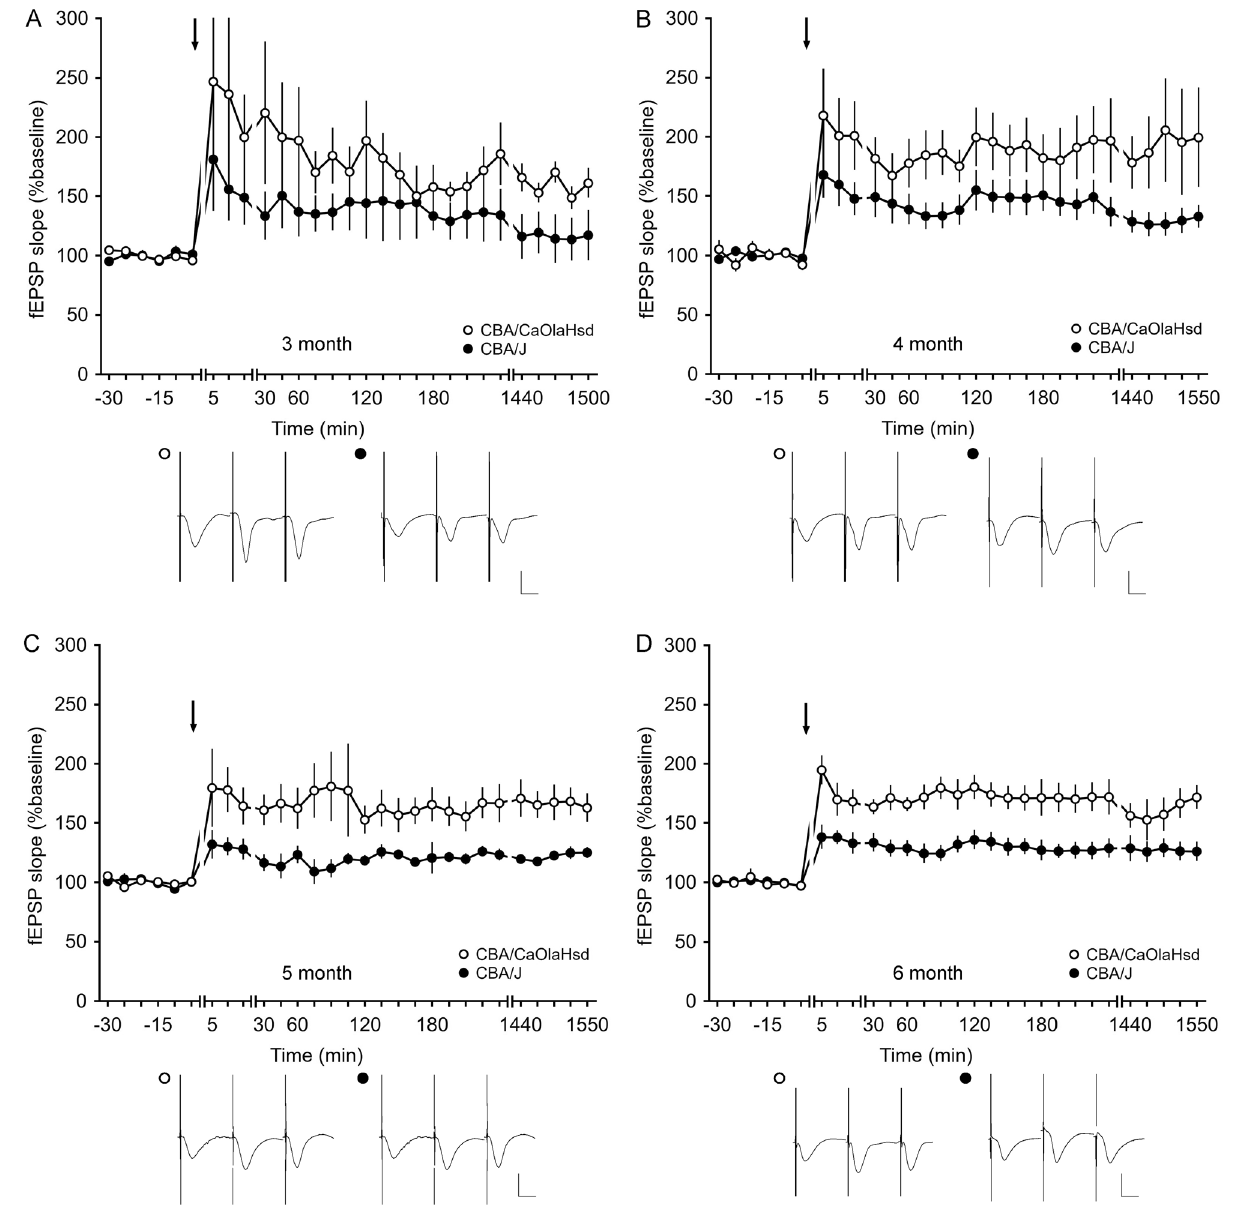
Figure 6. Comparison of hippocampal long-term potentiation of CBA/CaOlaHsd and CBA/J mice 3–6 months after birth. Long-term potentiation that lasted for longer than 24 h was elicited in CBA/CaOlaHsd and CBA/J mice by high frequency stimulation (HFS; 4 × 50 pulses at 100 Hz). ( A ) Three months after birth, CBA/ CaOlaHsd mice expressed LTP which was not statistically different to LTP in CBA/J (blind) mice. However, 4 ( B ), 5 ( C ) and 6 ( D ) months after birth, CBA/CaOlaHsd mice showed significantly larger LTP than in CBA/J mice of the same age. Line breaks indicate change in time scale. Arrows depict the time of stimulation. Analogs represent responses before stimulation, after stimulation and 24 h after stimulation in CBA/CaOlaHsd (open circles) and CBA/J (closed circles) mice. Vertical scale bar: 2 mV; horizontal scale bar: 10 Eleven months after birth, CBA/J mice still showed impaired LTP compared to LTP evoked in CBA/CaOlaHsd mice (n = 6) (ANOVA, F 1,11 = 5.37, p < 0.05; interaction effect : F 21, 231 = 0.43; p = 0.99; n = 7; Fig. 7C). However, by 12 months of age, a significant recovery of the early phase of LTP (5 min post-HFS) became evident in CBA/J mice compared to controls. Here, not with standing, late-LTP (> 120 min HFS) was still impaired compared to responses evoked in CBA/CaOlaHsd mice (ANOVA, F 1,9 = 7.92, p < 0.05; interaction effect : F 13 ,117 = 0.44; p = 0.95; n = 4; Fig. 7D), although early LTP was not statistically different between strains (ANOVA, F 1,9 = 0.98, p = 0.35; interaction effect: F 8 ,72 = 0.79; p = 0.62; n = 7; Fig. 7D). Supplementary Fig. S2 shows a summary of short-term (1–3 h after HFS) and long-term (3-24 h after HFS) changes in synaptic responses between CBA/CaOlaHsd and CBA/J mice at all ages that were tested.